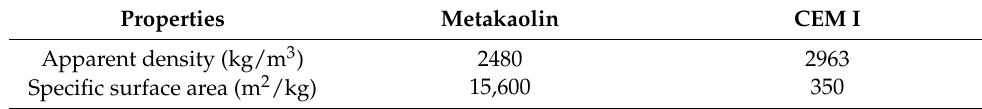
Table 1. Physical properties of metakaolin and CEM I.